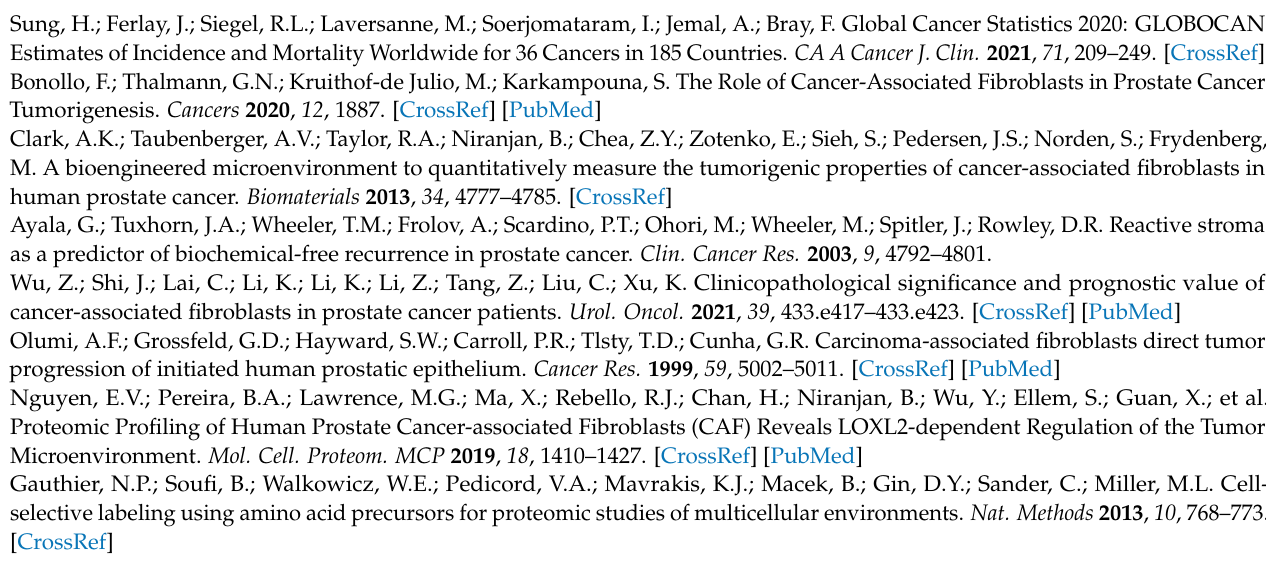
Figure S1: Changes in TGM2 signalling pathways in BPH-1 cells following CAF